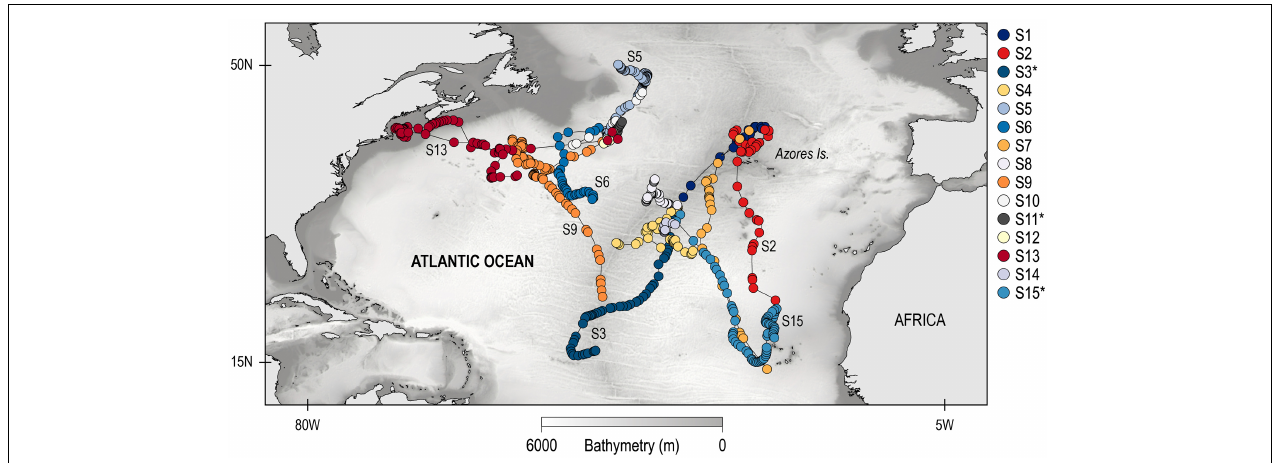
FIGURE 1 | Individual geolocations for 15 blue sharks tracked in the North Atlantic Ocean between 2010 and